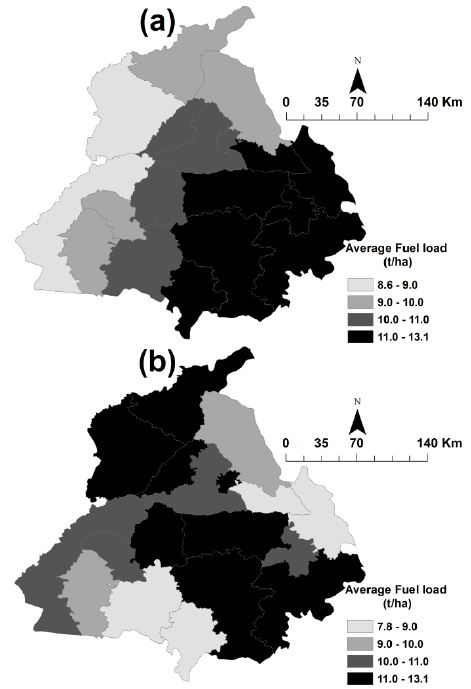
Figure 7. Spatial distribution of average fuel load (t/ha) during (a) rice and (b) wheat harvesting seasson.